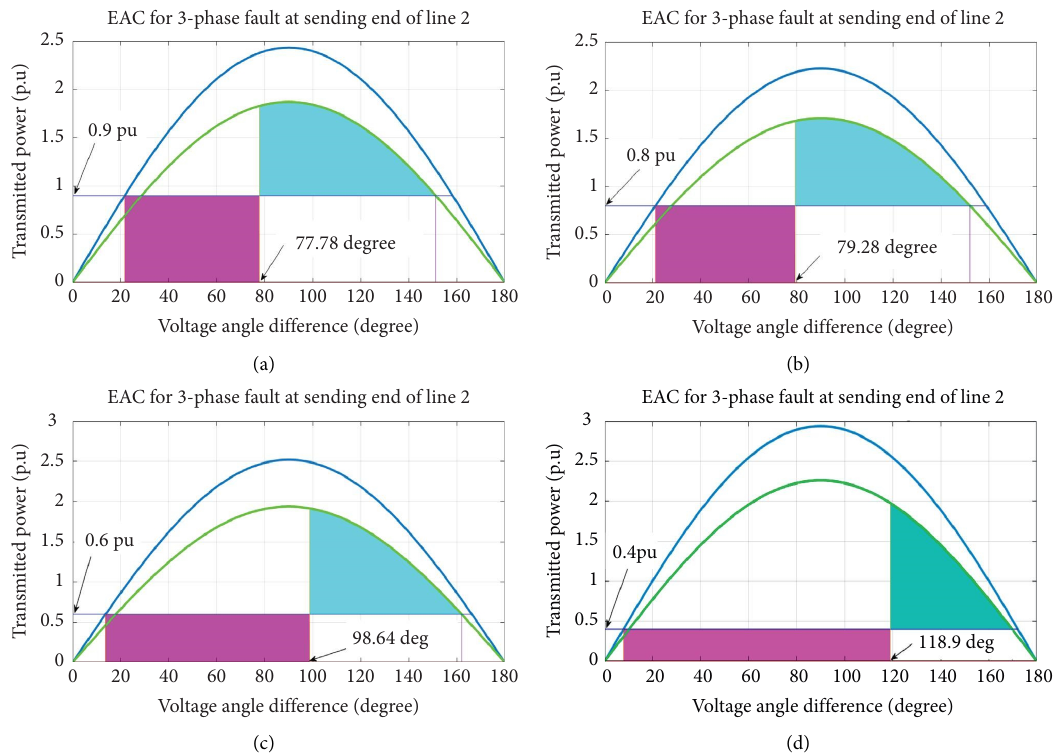
Figure 8: SMIB equal area criteria for diferent values of active power: (a) 0.9pu, (b) 0.8pu, (c) 0.6pu, and (d)